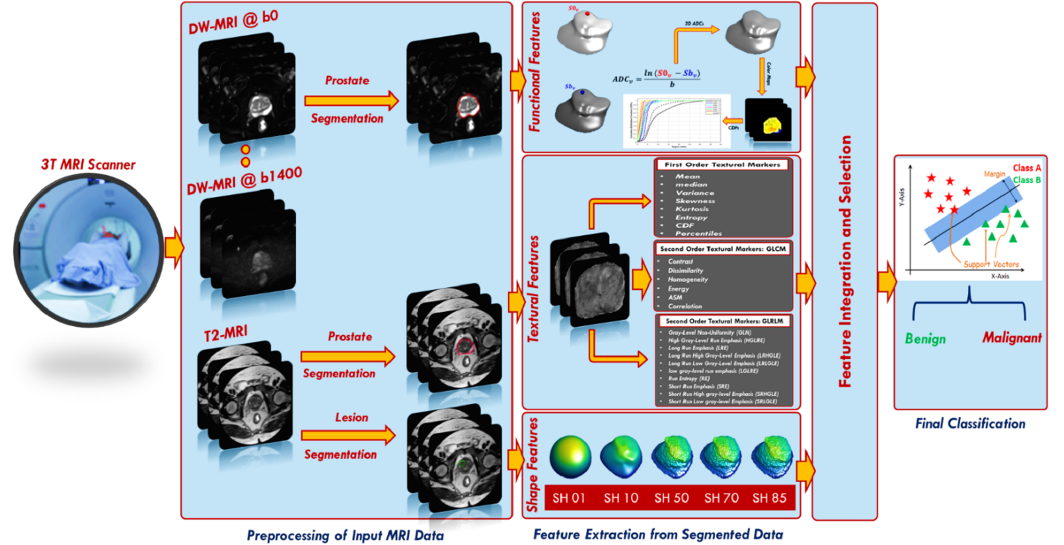
Figure 1. The proposed framework for early detection of prostatic adenocarcinoma.